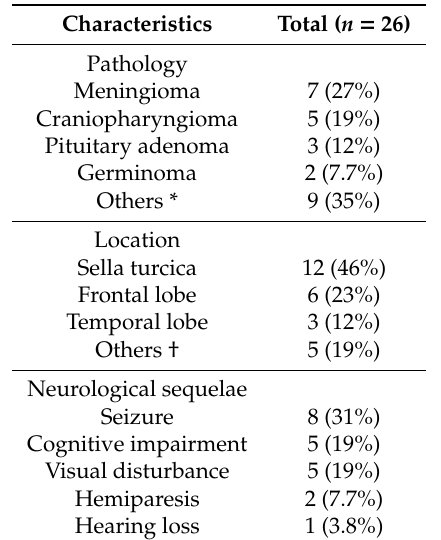
Table 1. Characteristics of brain tumor and neurological morbidities after surgical removal.